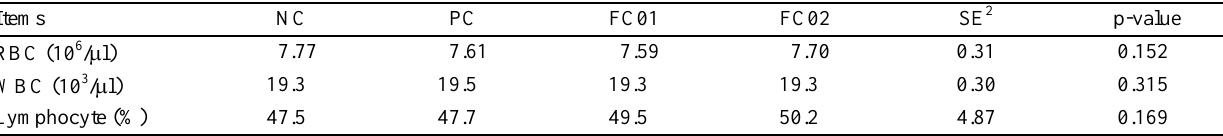
Table 4. Effect of fermented chlorella supplementation on blood profiles in growing pigs 1 Items NC PC FC01 FC02